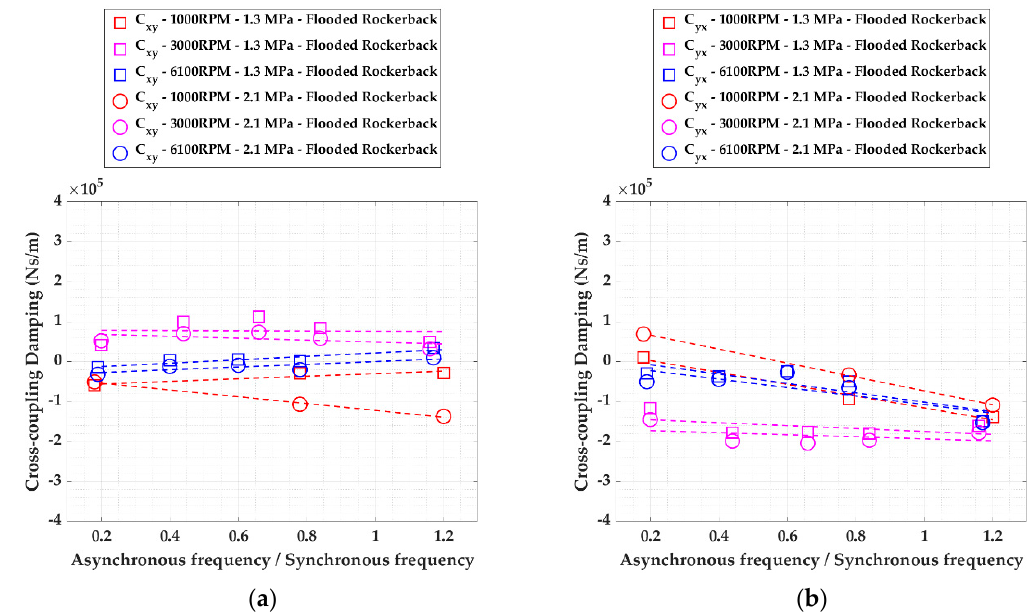
Figure A9. Flooded Rocker Pivot bearing asynchronous cross-coupling damping coefficients at various speeds for 1.3 MPa and 2.1 MPa: ( a ) C xy , ( b ) C yx .